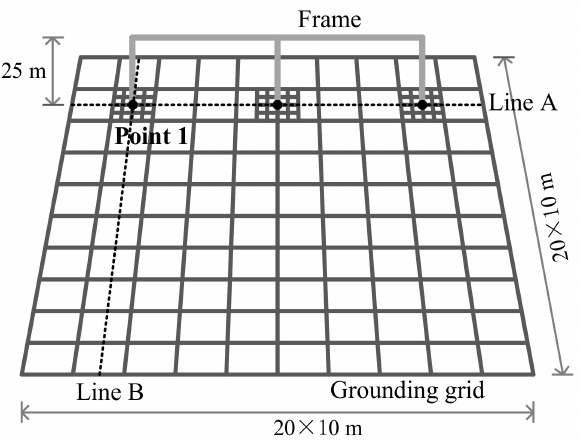
Figure 7. Layout of the grounding grid and the frame.